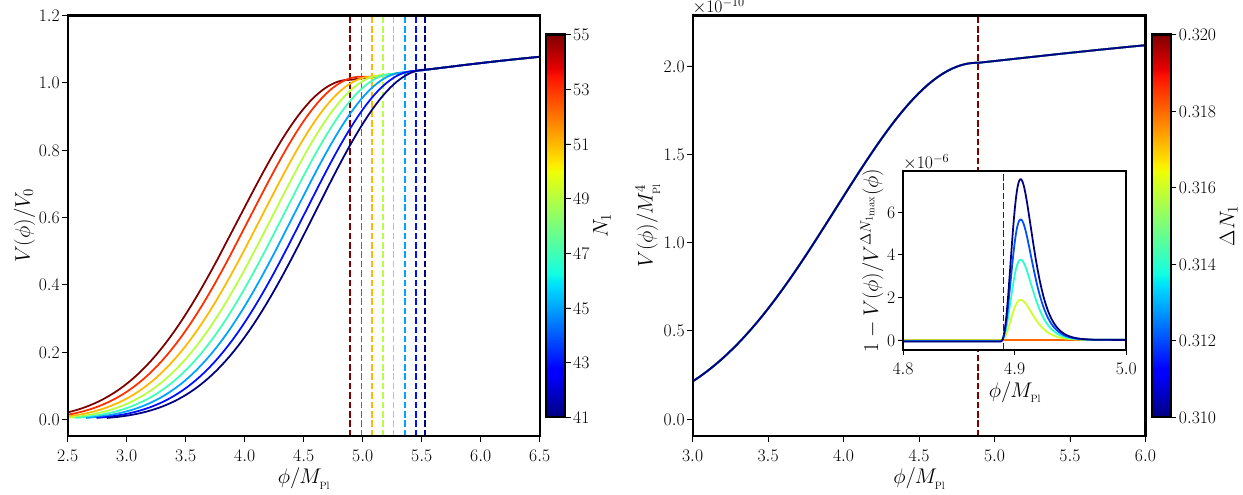
Figure A2. The shape of the potential obtained from reconstruction is presented for a range of values of N 1 (on the left ) and ∆ N 1 (on the right ). Understandably, the change in N 1 moves the location of the point of inflection (marked with dashed lines of respective colors). The variation in ∆ N 1 leads to imperceptibly small change in the shape of the potential around the point of inflection. This can be better observed in the relative difference between a given V ( φ ) and the one corresponding to the maximum value of ∆ N 1 , as plotted in the